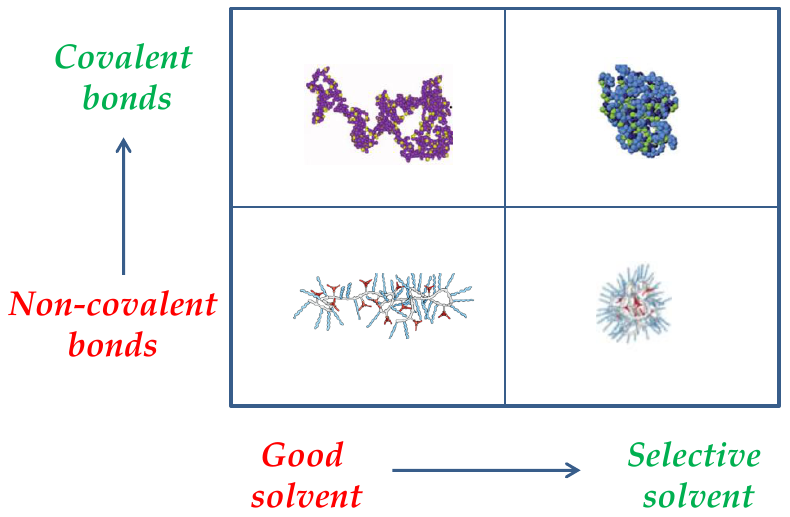
Figure 3. Interplay between intra-chain interactions and solvent quality on the resulting SCNP morphology and size (draws taken with permission from [9], Copyright Society of Chemical Industry, 2016 and [23], Copyright American Chemical Society, 2014).